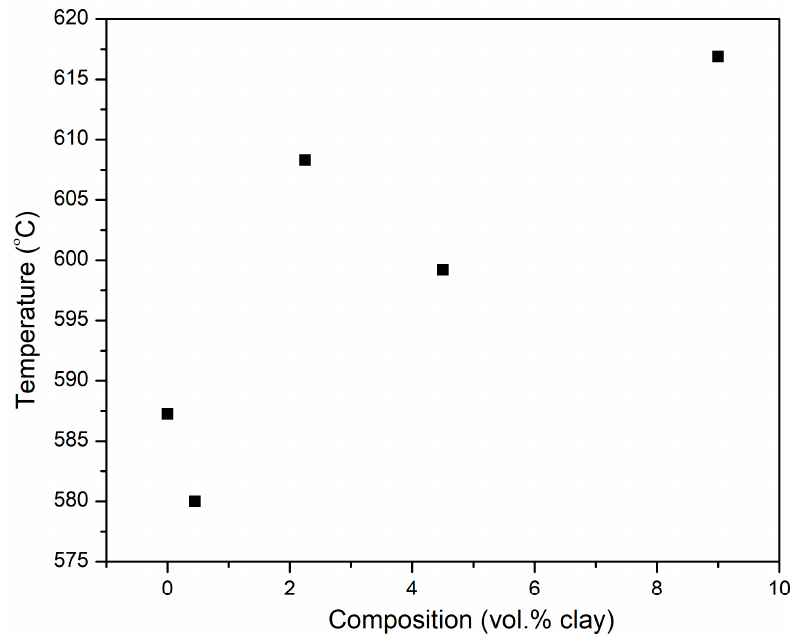
Figure 15. Variation of the onset temperature of decomposition of PI-NGS-Clay nanocomposites as a function of composition.